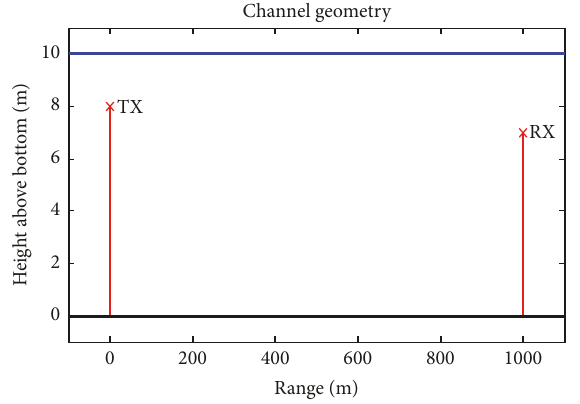
Figure 2: Model simulation diagram.